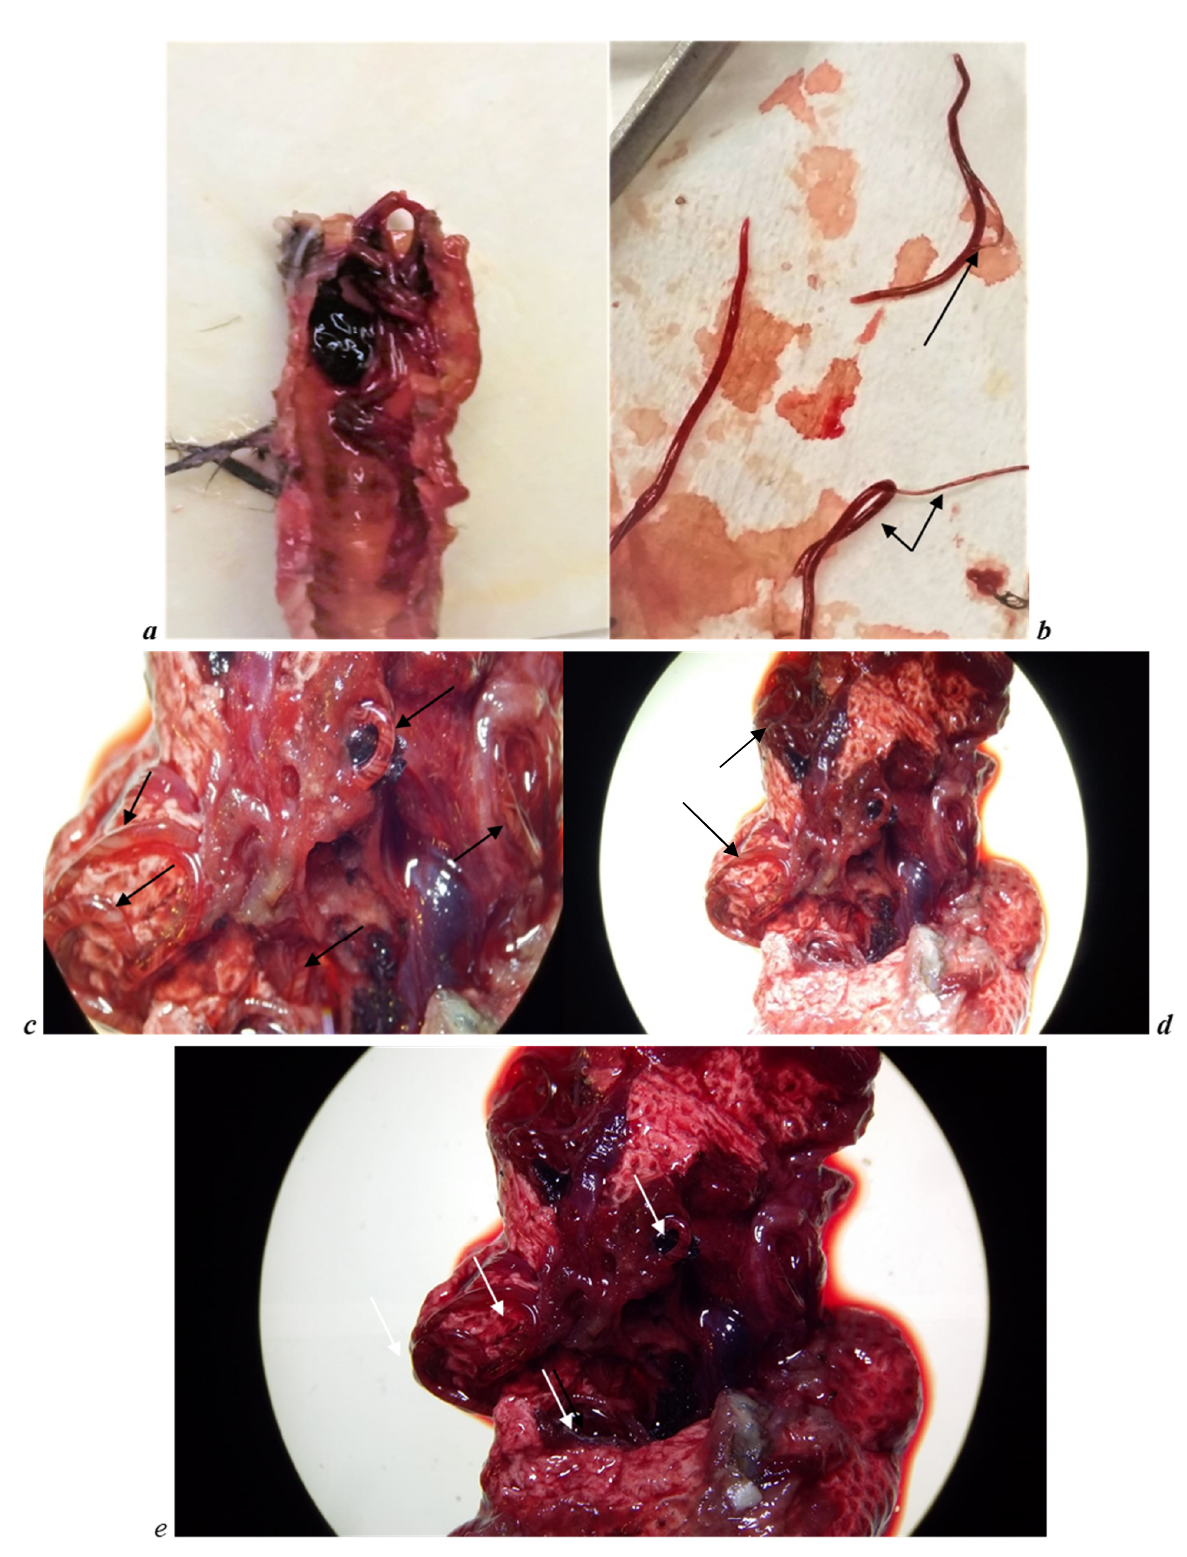
Figure 2. ( a ) Tracheal lumen with nematodes and blood clots. ( b ) Nematodes in the Y-shape form (copula), as shown in the figure by the arrows. ( c – e ) Pulmonary oedema and haemorrhagic flooding with the presence of numerous nematodes, as shown in the figure by the arrows.